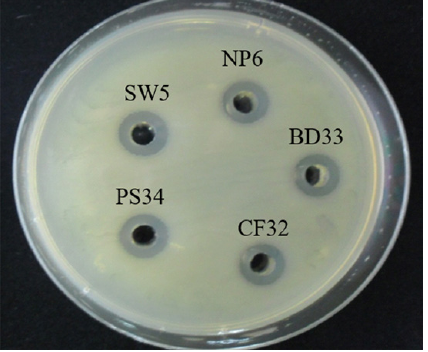
Fig. 1. Inhibitory effect of untreated CFS from overnight cultures of 5 strains of P. pentosaceus in MRS broth Table 2. Antibiotic resistance profiles of Salmonella isolated from vegetables and fermented meats Salmonella